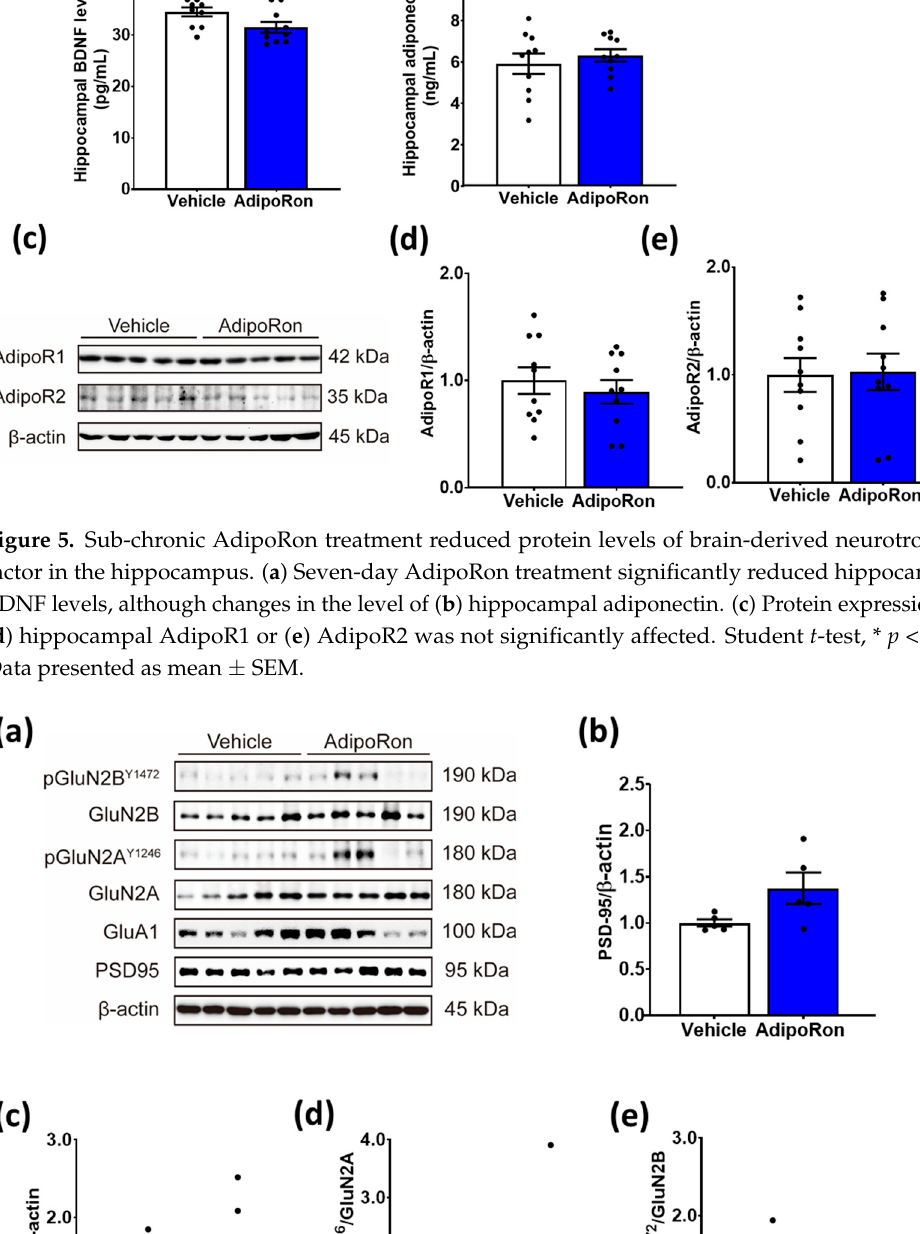
Figure 5. Sub-chronic AdipoRon treatment reduced protein levels of brain-derived neurotrophic factor in the hippocampus. ( a ) Seven-day AdipoRon treatment significantly reduced hippocampal BDNF levels, although changes in the level of ( b ) hippocampal adiponectin. ( c ) Protein expression of ( d ) hippocampal AdipoR1 or ( e ) AdipoR2 was not significantly affected. Student t-test, * p < 0.05. Data presented as mean ± SEM.